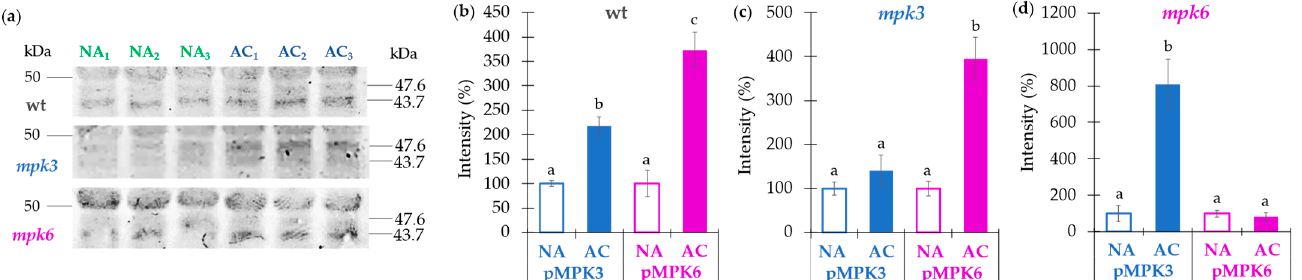
Figure 6. Effect of cold acclimation on the phosphorylation of MPK3 and MPK6 from wild type, mpk3 , and mpk6 plants. ( a ) Immunodetection (Western blot) of the phosphorylated forms of MPK3 and MPK6 (pMPK3 and pMPK6, respectively) in NA or AC wild type, mpk3 and mpk6 plants. NA 1–3 , and AC 1–3 , correspond to three biological replicates. ( b – d ) Densitometric quantification of the protein bands in ( a ). ( b ) Levels of pMPK3 and pMPK6 in NA and AC wild type plants. ( c ) Levels of pMPK3 and pMPK6 in NA and AC mpk3 plants. ( d ) Levels of pMPK3 and pMPK6 in NA and AC mpk6 plants. Loading control gels are presented in Figure S3b–d. Normalization of the protein bands in the Western blots was performed considering the intensity of the corresponding lane in the Coomassie stained gel and the blot background when different blots were compared. Values presented in panels ( b – d ) are means of three biological replicates ± SE. α ≤ 0.05 (ANOVA test). Different letters indicate significant differences.